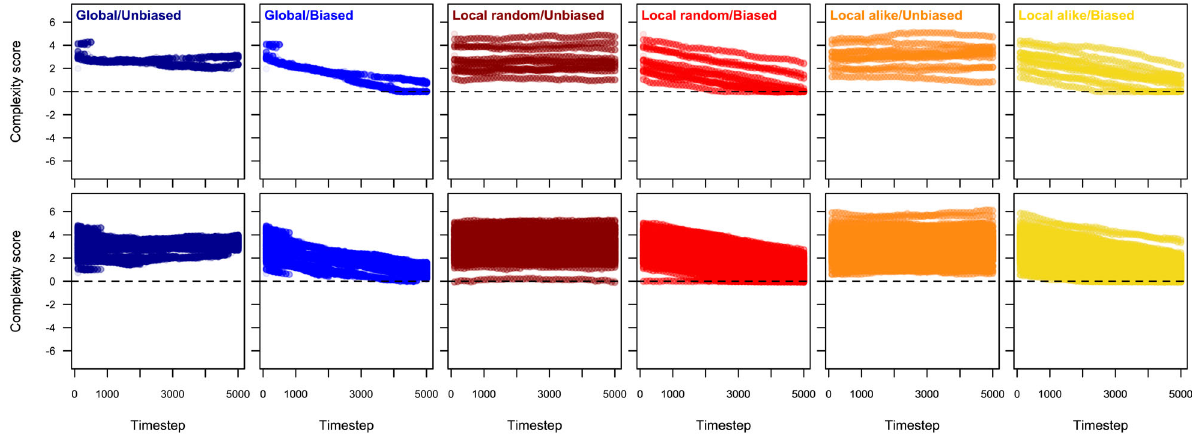
Fig. 5 Plots illustrating representative trends in individual simulations for small (n = 100) versus large (n = 1000) populations. Plots illustrating typical trends in tune complexity (where 0 = intermediate and positive and negative scores higher and lower complexity, respectively) over time in a small (top row, n = 100) and b large (bottom row, n = 1000) simulated populations across the six simulation conditions: global populations with unbiased copying, global populations with intermediate-biased copying, randomly selected local populations with unbiased copying, randomly selected local populations with intermediate-biased copying, assortatively selected local populations with unbiased copying and assortatively selected local populations with intermediate- biased